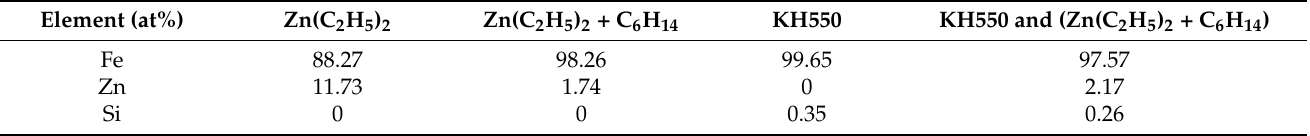
Table 1. Elemental effects of different treatments on the prepared powders.